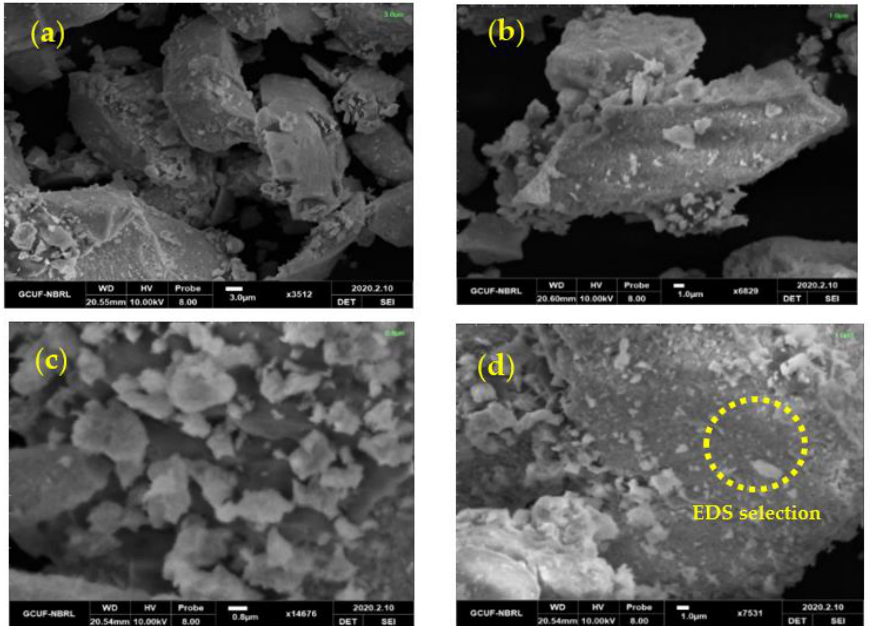
Figure 2. Scanning electron microscopy images of the La 2 ZnO 4 nanocomposite at different resolutions ( a ) at 3.0 μm ( b ) 1.0 μm ( c ) 0.8 μm ( d ) Selection of EDX on SEM Pattern.